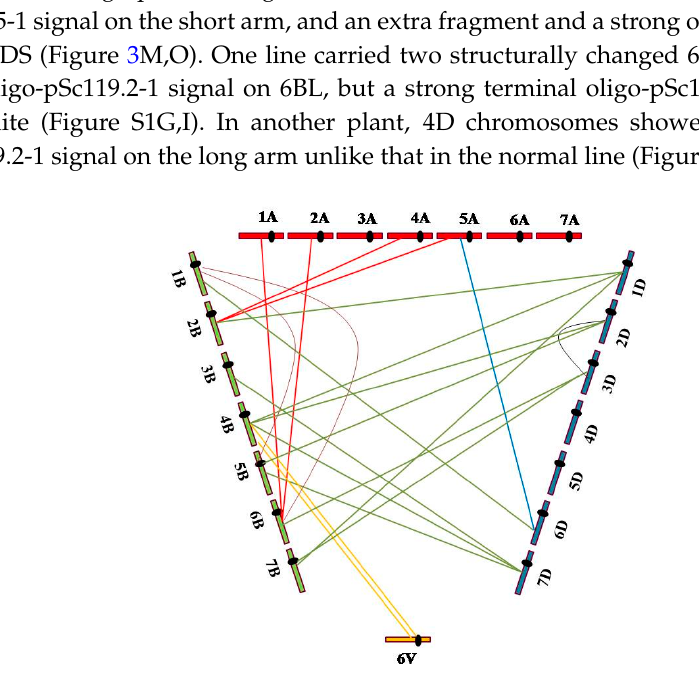
Figure 4. Distribution of interchromosomal translocation events on chromosomes of A, B, and D wheat genomes and the alien chromosome 6V from Dasypyrum villosum .